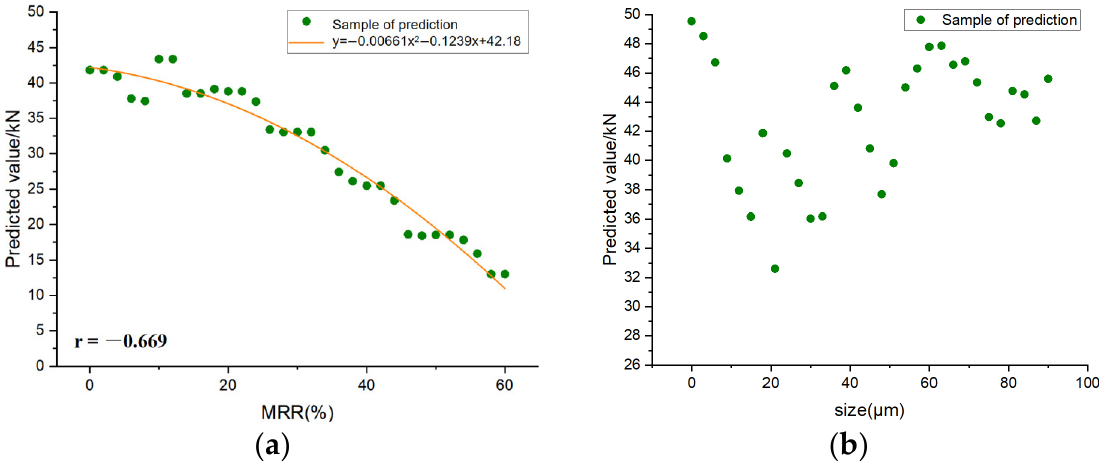
Figure 15. RBP feature sensitivity analysis diagram. ( a ) mass replacement rate; ( b ) size.